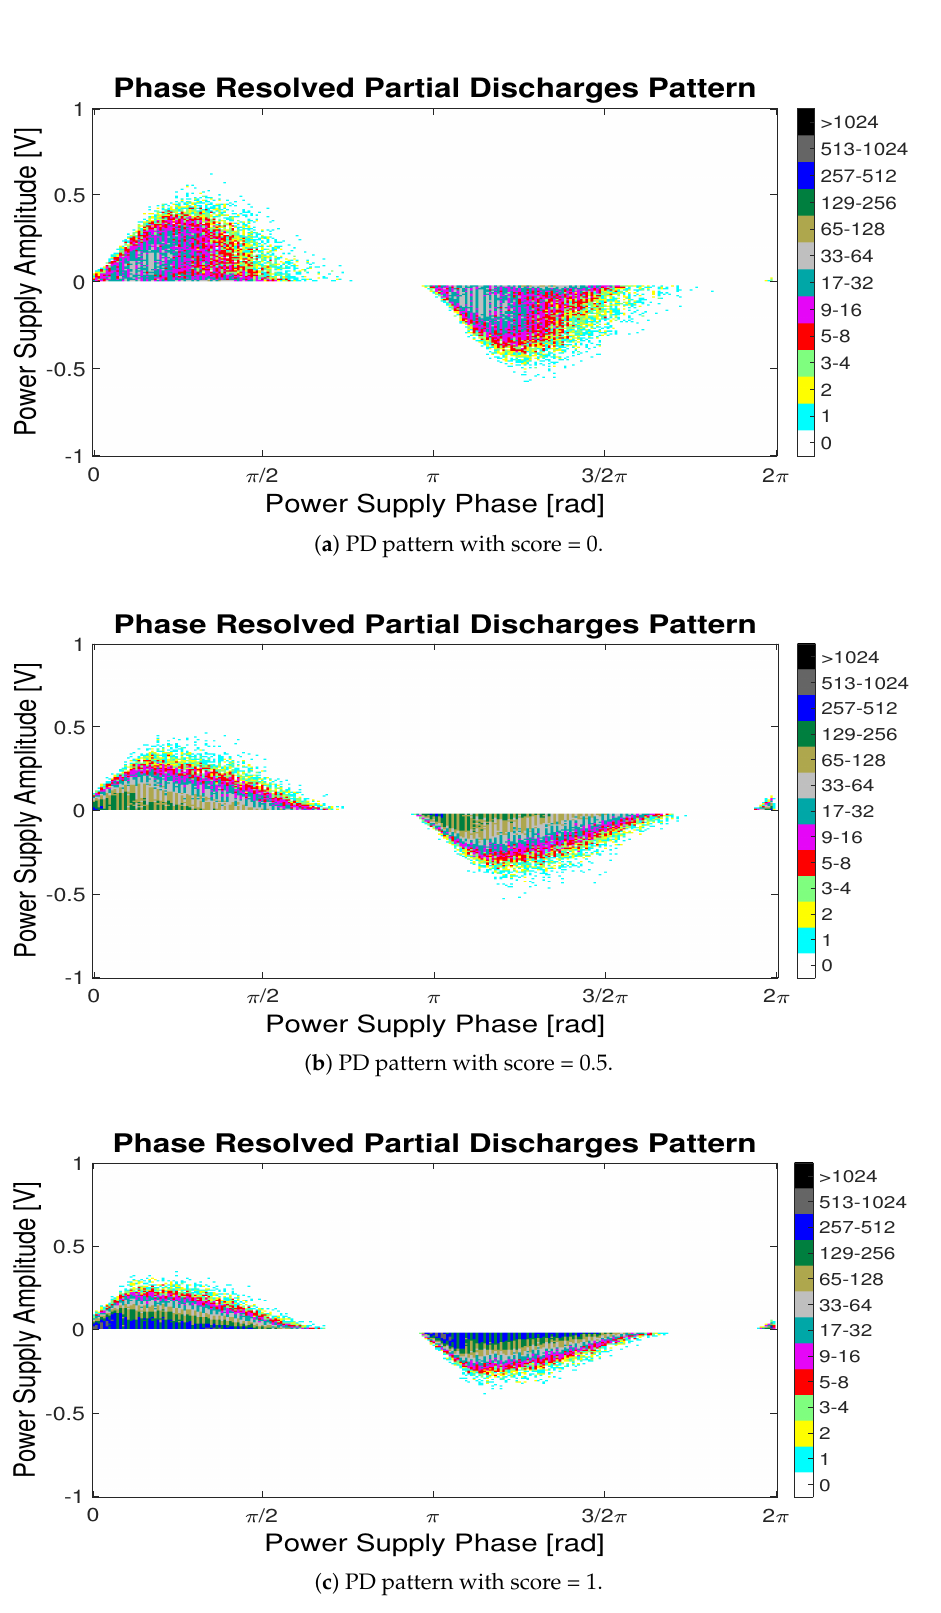
( c ) PD pattern with score = 1. Figure 4. PD Patterns acquired from a specimen aged with a supply voltage of 2000 V at ( a ) the PD activity inception time (score = 0), ( b ) half of the life time (score = 0.5), and ( c ) at the breakdown time (score =